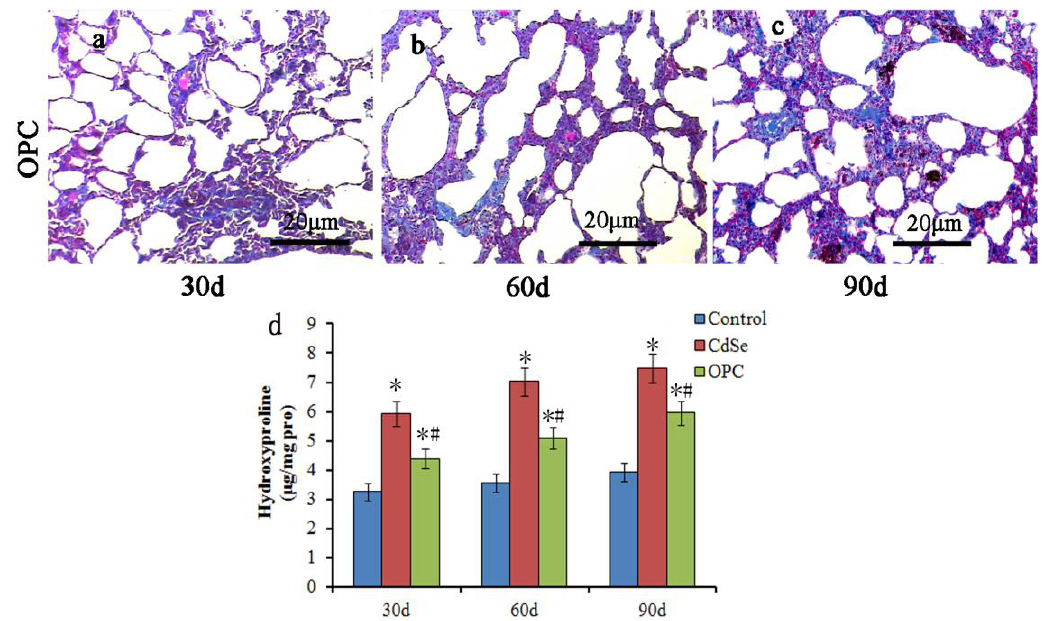
Figure 5. Masson trichrome stain in assessing the pulmonary fibrosis by the OPC effect. The collagen level decreased sharply in the OPC intervention groups compared with that in the CdSe groups at 30 ( a ), 60 ( b ), and 90 ( c ) days, respectively. OPC decreased the hydroxyproline levels effectively in the OPC-treated pulmonary fibrosis lung tissues when comparing with the CdSe groups ( d ). (* p < 0.05, as compared with the normal control groups, # p < 0.05, as compared with the CdSe groups). The above typical pictures are selected from the lung tissues of 8 rats in each group.